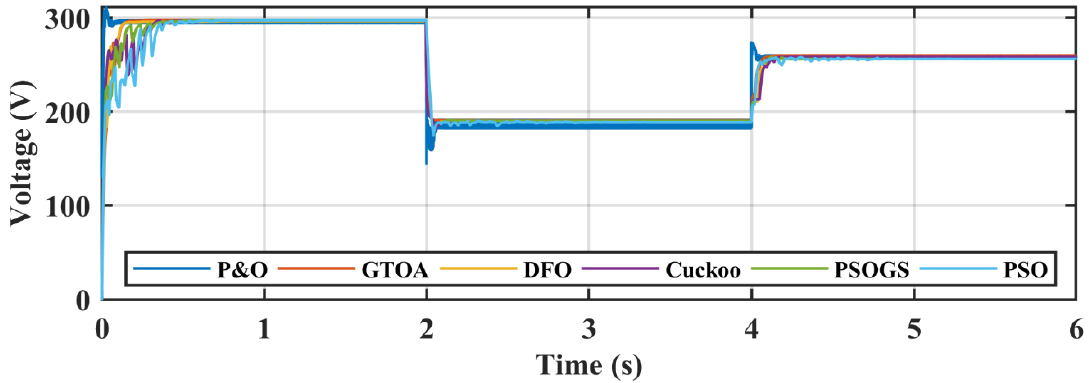
Figure 12. Zoomed-in comparison of duty cycle of GTOA.